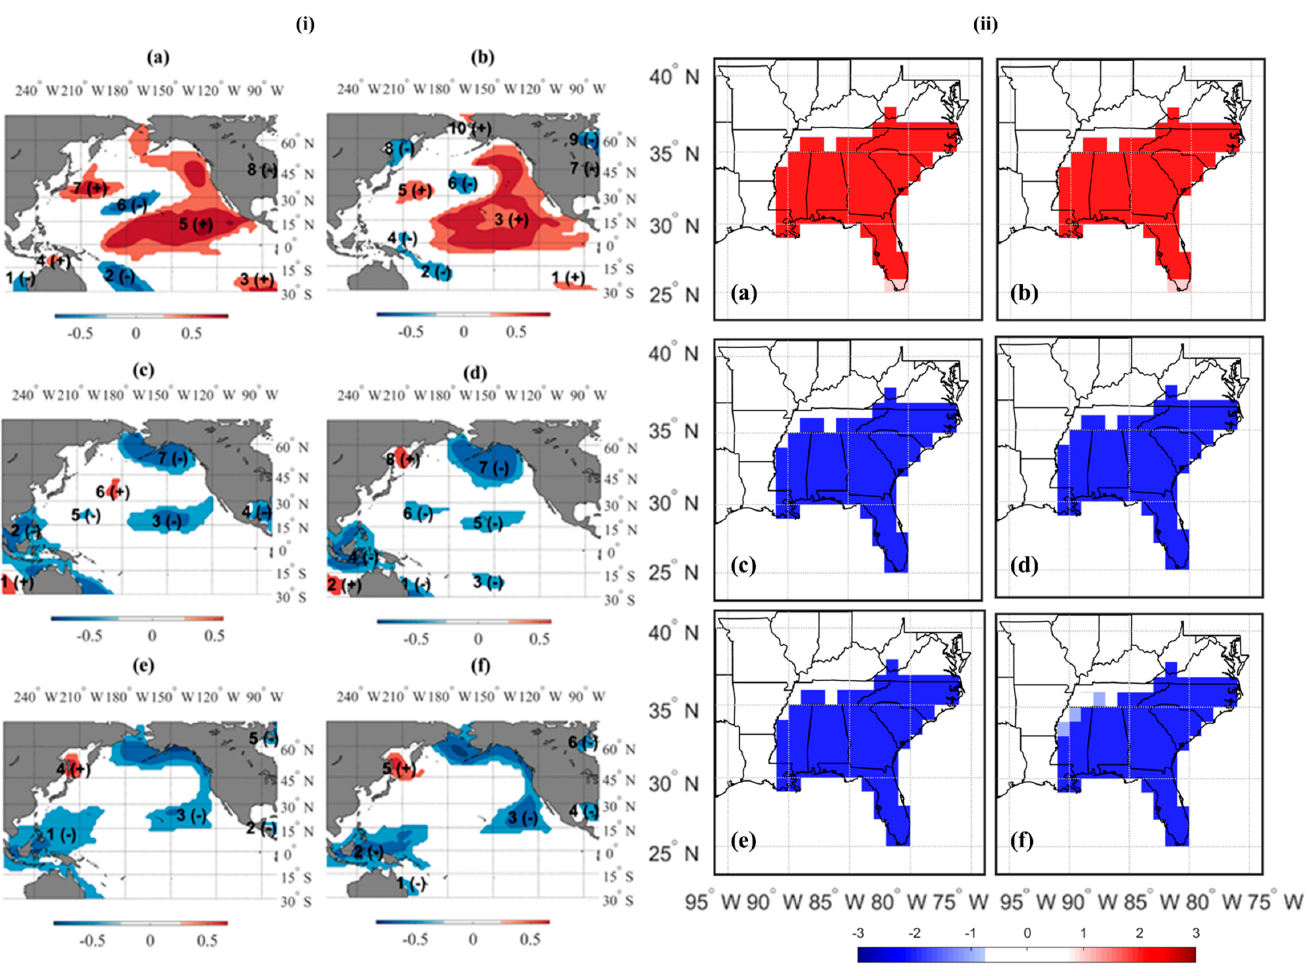
Figure 3. Teleconnection patterns heterogeneous correlation plots showing of the ( i ) Pacific Ocean SST with ( ii ) TWSA of the HUC-03 watershed region. ( a ) June-SST Nov-TWSA; ( b ) July-SST Dec-TWSA; ( c ) Aug-SST Jan-TWSA; ( d ) Sept-SST Feb-TWSA; ( e ) Oct-SST March-TWSA; and ( f ) Nov-SST April-TWSA.